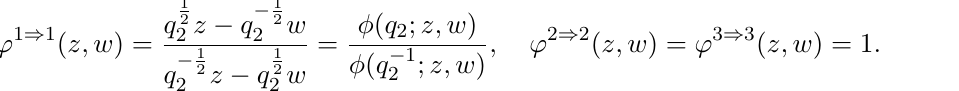
are m 0 5 5 , m 5